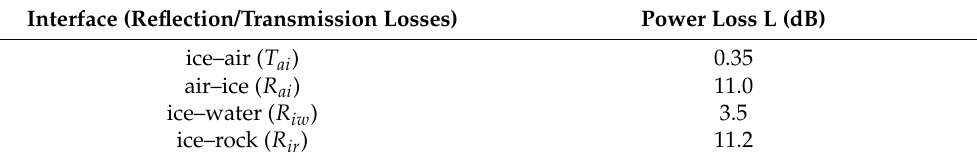
Table 2. Power loss of interface